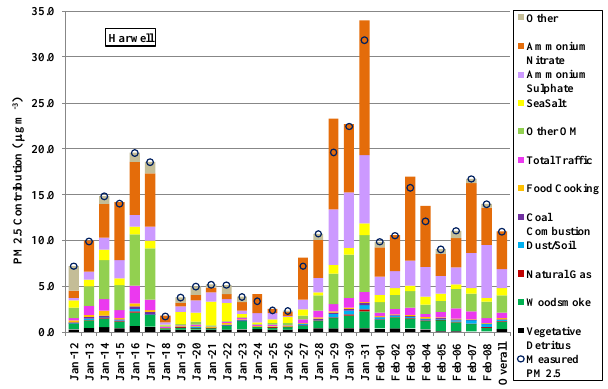
Figure 4. Daily PM 2 . 5 source contribution estimates at HAR.